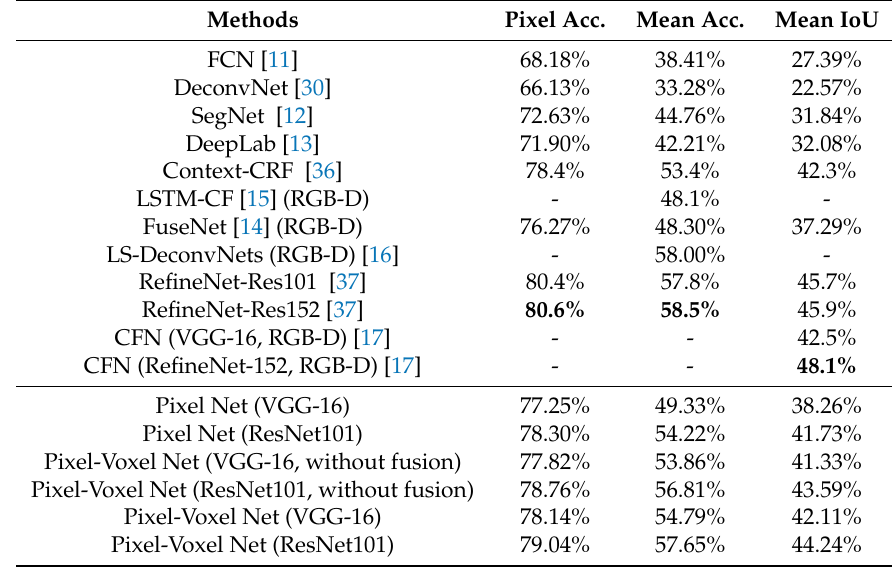
Table 1. Comparison of the overall performance on the SUN RGB-D dataset. Some results are copied from [12]. The best performance among the compared methods is marked as bold.